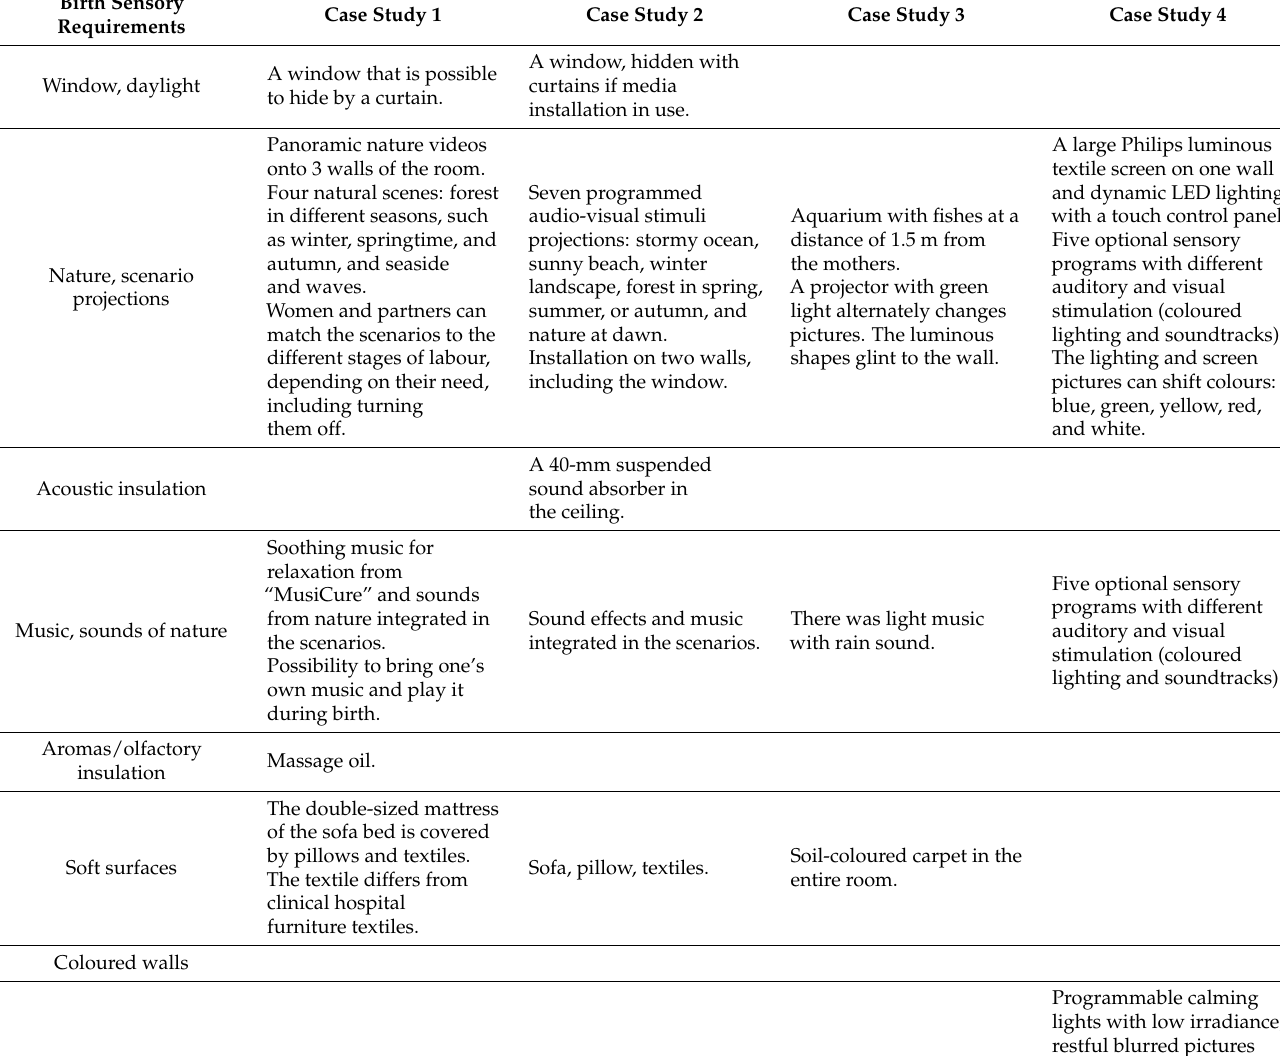
Table 4. Birth sensory requirements: solutions